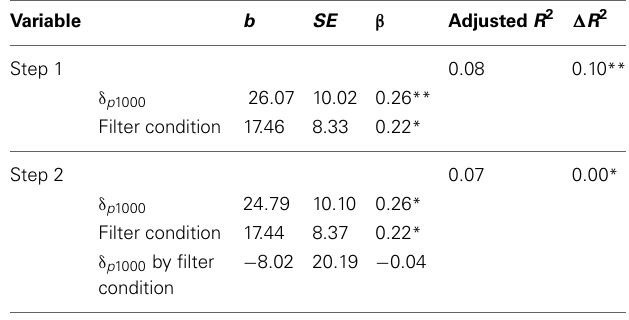
Table 4 | Results of the hierarchical regression